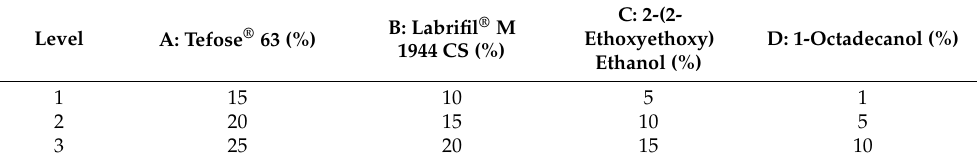
Table 1. Influencing factors and levels of cream formula (before